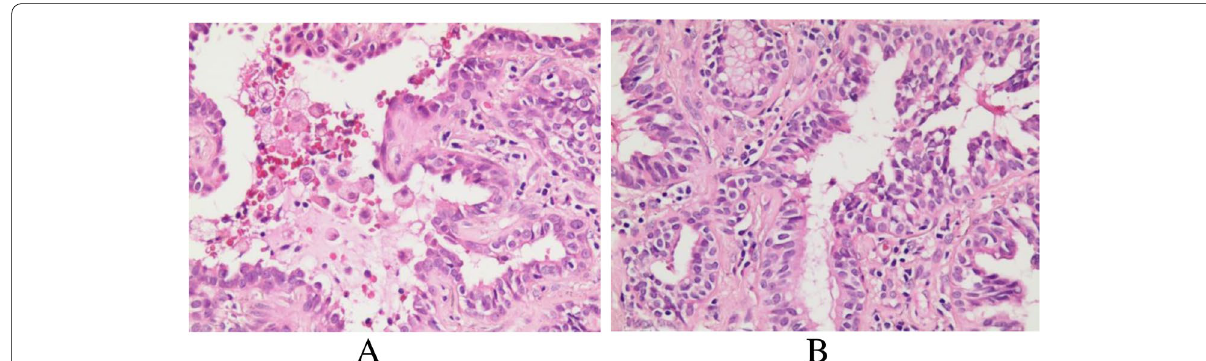
Fig. 3 A Hematoxylin and eosin staining (H&E) of loupe image. A Tumor cells are proliferating along the alveolar walls, surrounded by mucous lakes, B Tumor cells are proliferating along the alveolar walls, consisting of ciliated columnar cells and goblet cells with